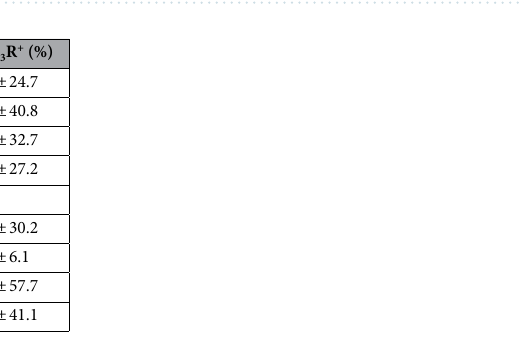
Table 1. Numbers (means ± SD in %) of GAL 2 R- and GAL 3 R-positive (GAL 2 R + or GAL 3 R + ) neutrophilic granulocytes in human colon specimen of patients diagnosed with Crohn’s disease (CD) or ulcerative colitis